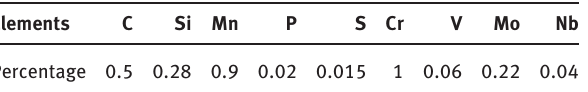
Table 2: Chemical composition of 50CrMo steel.